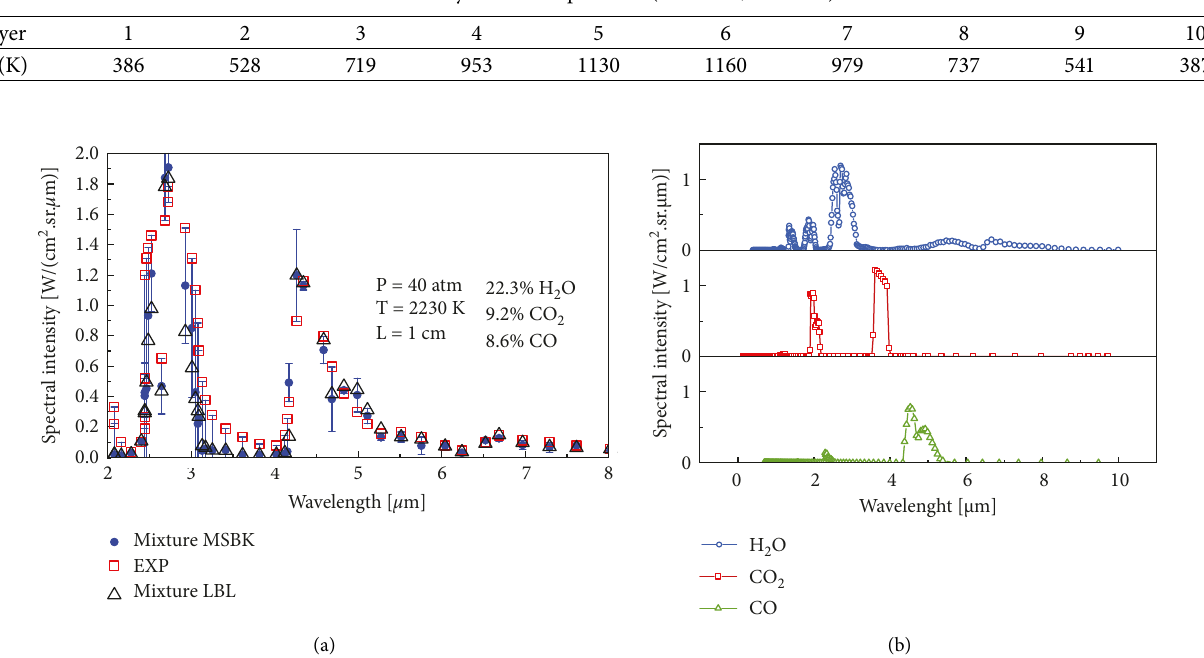
Figure 6: Comparison of experimental data and calculated spectral intensities using the MSBK model.